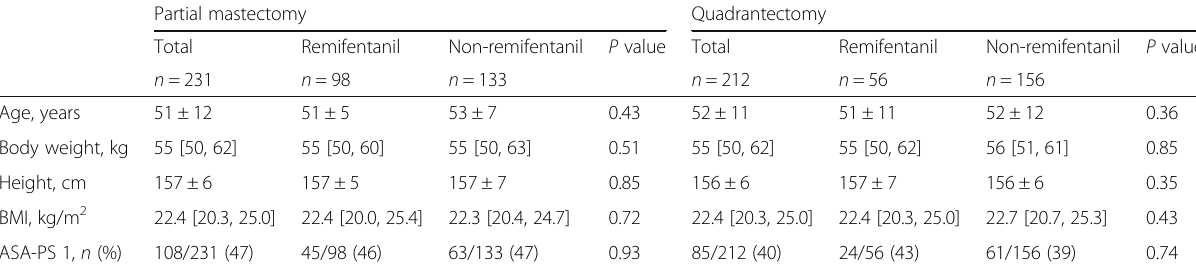
Table 1 Baseline characteristics of patients undergoing partial mastectomy Partial mastectomy Quadrantectomy